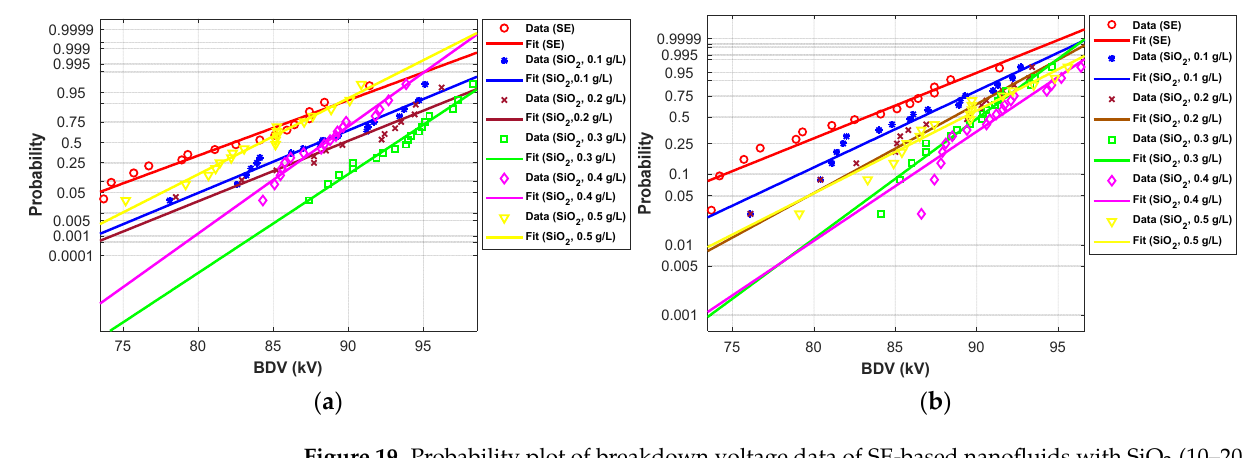
Figure 18. Probability plot of breakdown voltage data of SE-based nanofluids with ZrO 2 (20–30 nm) for 2.5 mm electrode gaps; ( a ) normal and ( b ) extreme value.